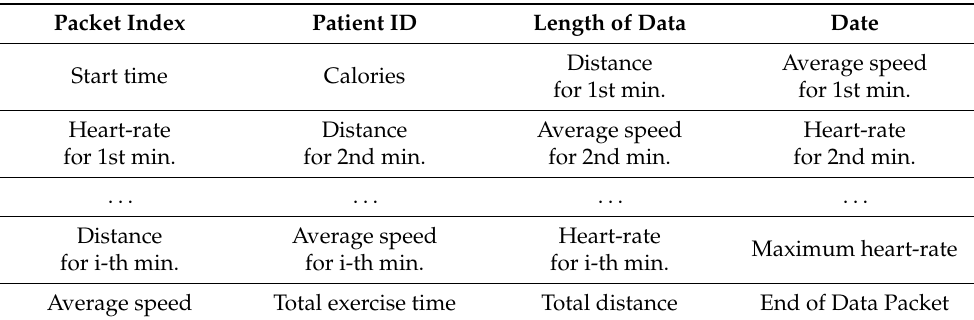
Table 2. A data packet format for the proposed therapeutic exercise platform.